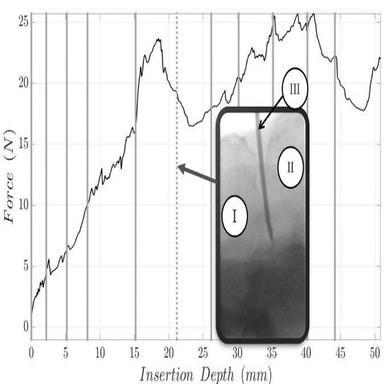
Force measurement with possible friction on the needle shaft; black line: insertion force over insertion depth; grey vertical lines: the positions when an x-ray image was taken; grey dotted vertical line: currently active x-ray image (lateral view) as indicated in the bordered detail: spinal processes of lumbar vertebrae L3 (I) and L2(II); 18-gauge Tuohy needle (III).